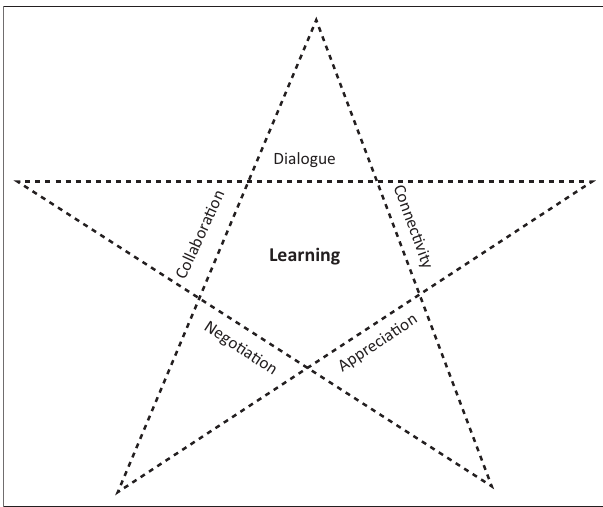
FIGURE 1: Web of conceptual